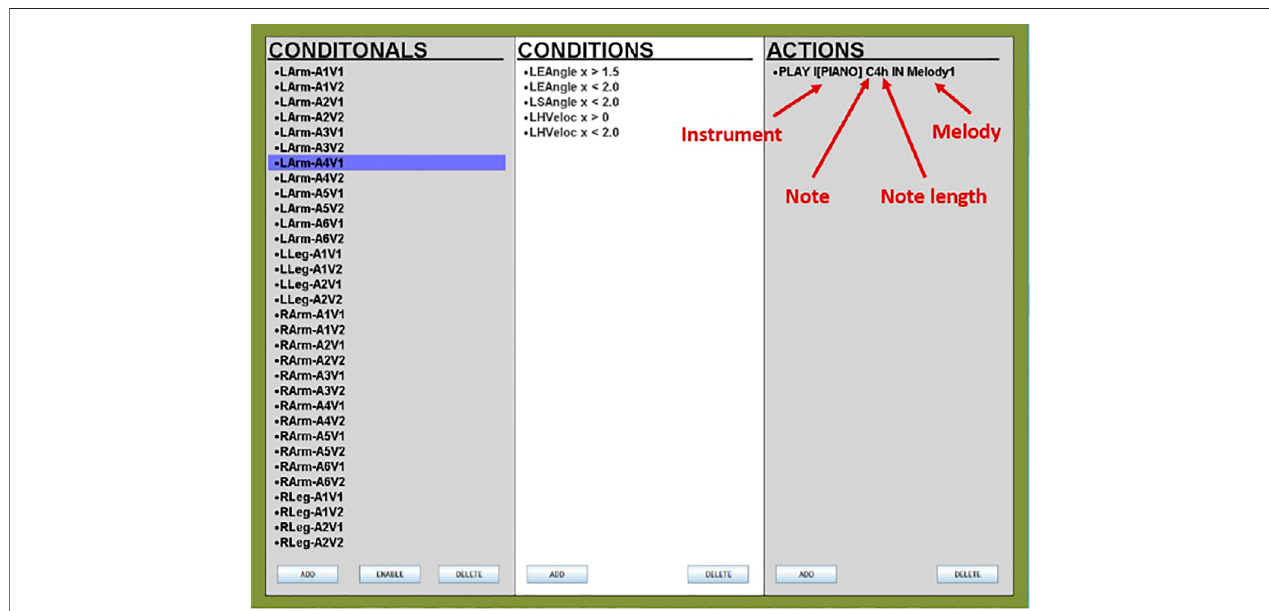
FIGURE3| Thegraphicaluserinterfaceweusedtode fi nethepose-to-musicmappingsinthemusicorchestrator(Alankusetal.,2005).Abreakdownoftheaction command that generates the music output is also shown, highlighting the instrument, note, note length, and melody settings.